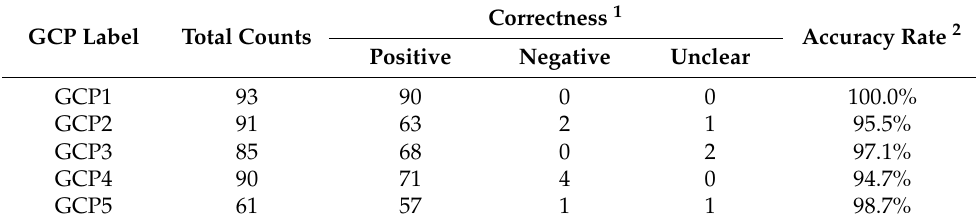
Table 5. The accuracy evaluation of GCP pixels positioning